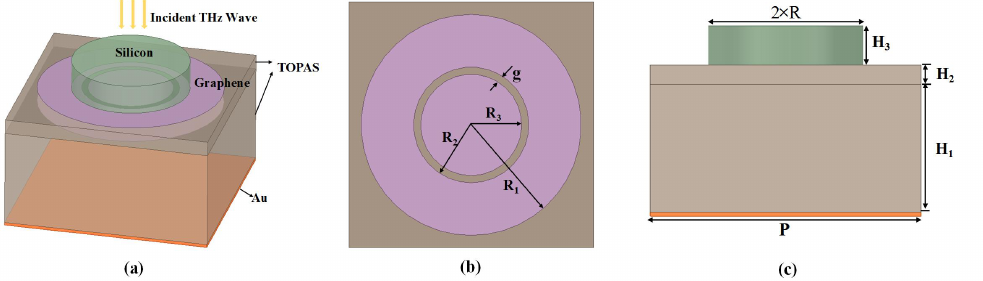
Figure 1. ( a ) Schematic of the proposed absorber. ( b ) Top view of the unit cell of patterned graphene, ( c ) Side view of the unit